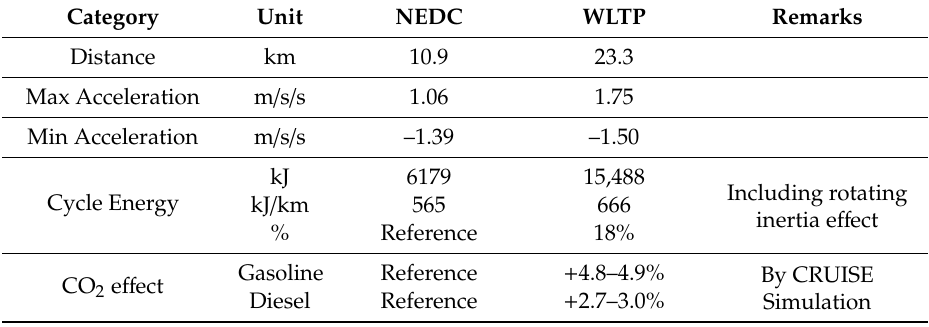
Figure 10. Speed and acceleration of WLTC and NEDC.